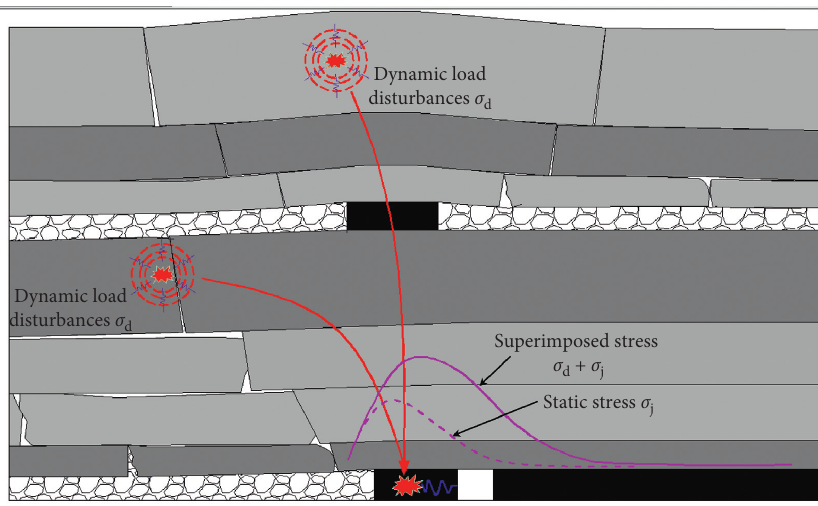
Figure 7: Dynamic disturbance diagram of mining retained pillar in close